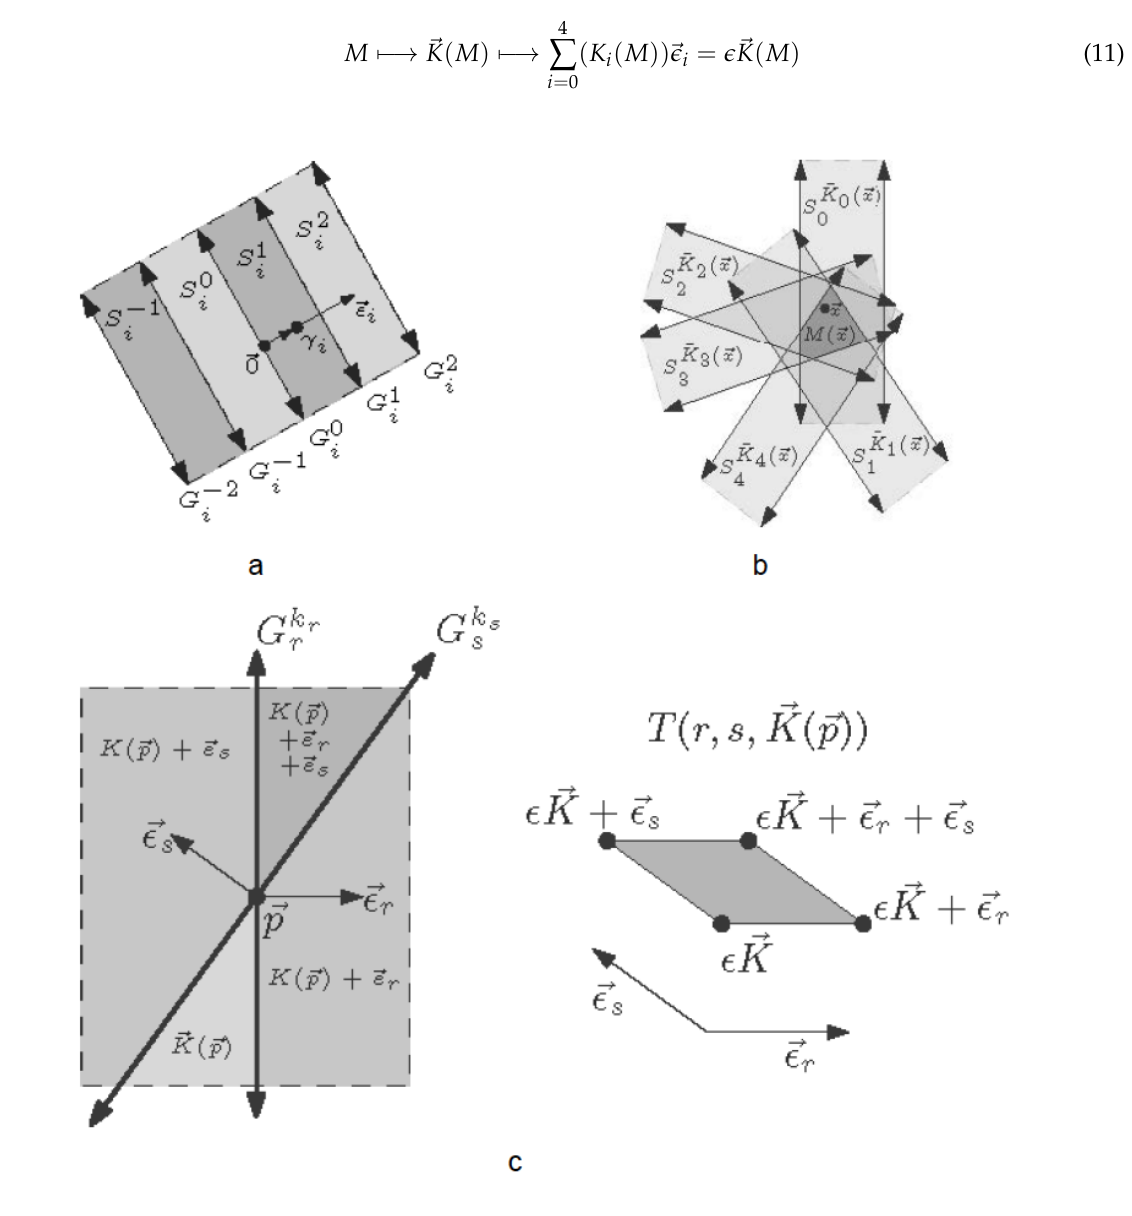
Figure 7. Calculating the coordinates of the vertices in the Penrose tiling using the indices of the corresponding mesh regions. ( a ) open strips S i in grid G i , where (cid:101) i is the norm of the G i and γ i is the shift vector; ( b ) a mesh region M ( x ) containing a point x , which is given by the intersection of strips from all five grids; ( c ) an intersection point in the grid and its corresponding tile in the tiling. ˜ k ˜ k (cid:126) p denote their intersection point, as shown in Figure 7c. r s Given two grid lines G r and G s , let